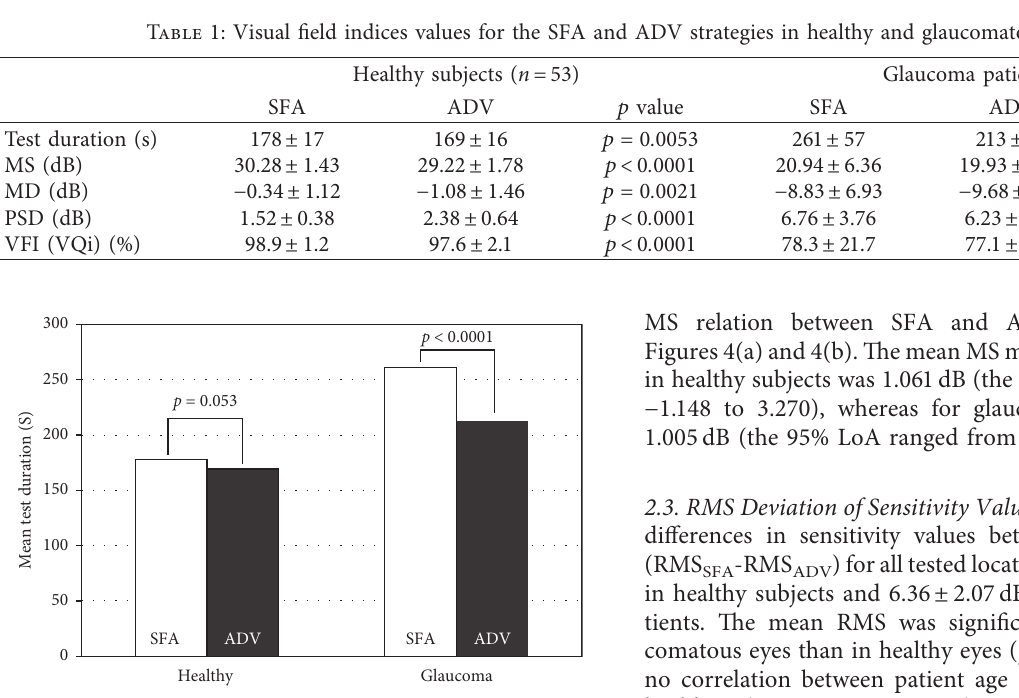
Figure 1: Mean SFA and ADV tests duration in the healthy and glaucoma